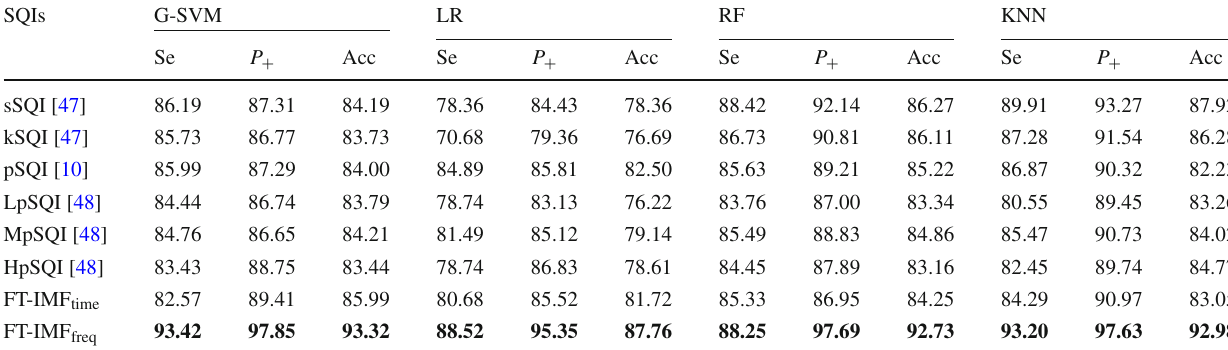
Table 4 Average results of five-fold cross-validation performed on set-a using four classifiers for each SQIs SQIs G-SVM LR RF KNN Se P + Acc Se P + Acc